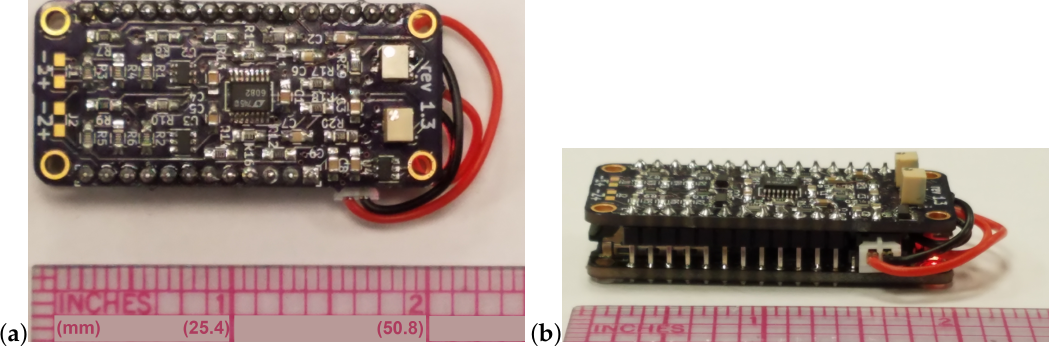
Figure 3. Data logger: bird’s-eye view ( a ) and eye-level view ( b